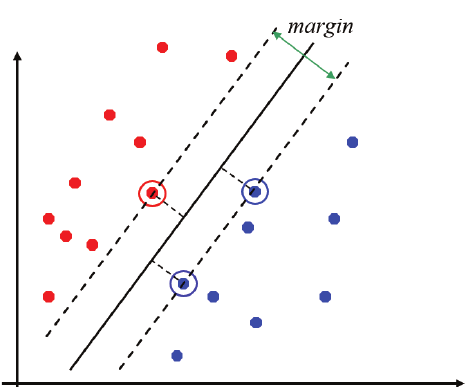
Figure 3. Th e hyperplane of the support vector machine (SVM)